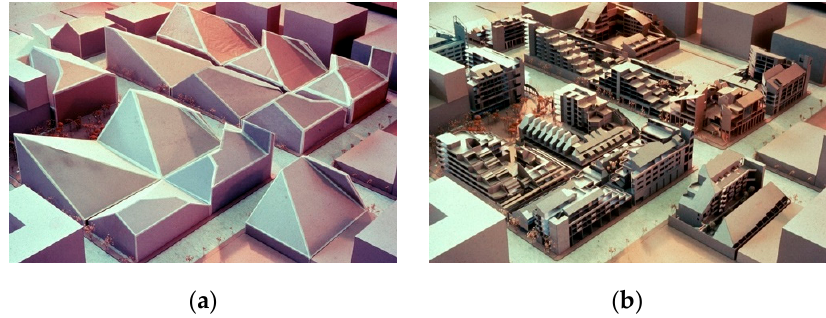
CONNECTION WITH THE SUN: STATIC OR DYNAMIC